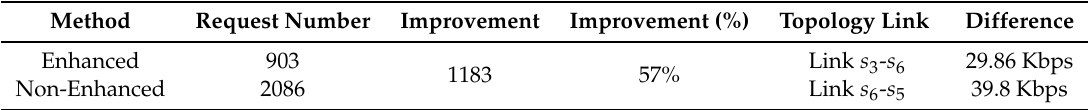
Table 5. Summary of Enhanced vs. Non-Enhanced Methods for Data Rate in Bridge-far video within Study Case B.